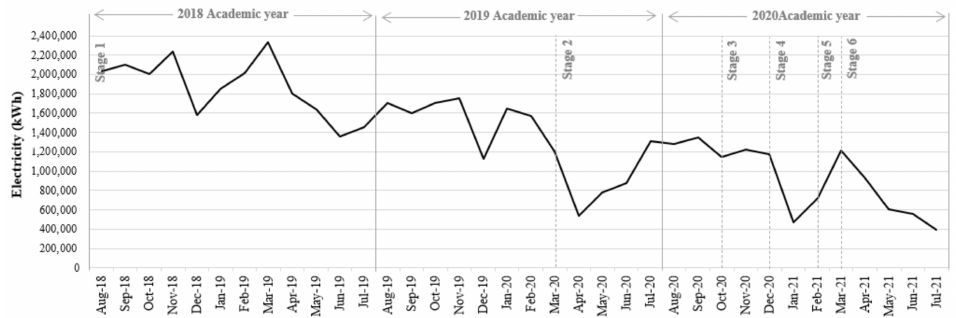
Figure A1. Electricity consumption of the academic type during AY2018 to AY2020.